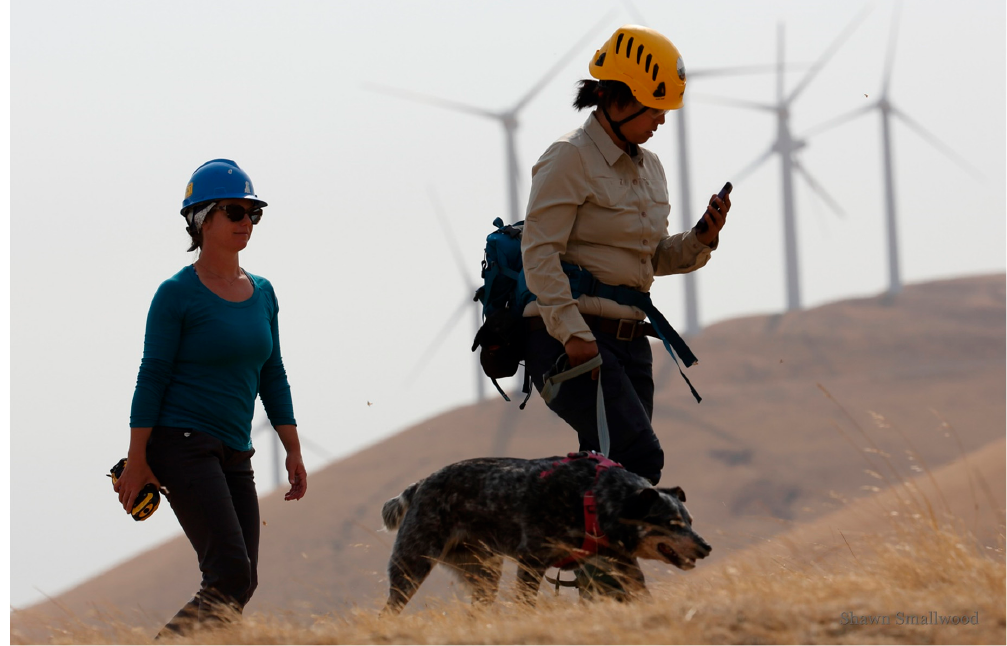
Figure 5. Jack leads handler Collette Yee and data collector/orienteer Skye Standish in a fatality search at Buena Vista Wind Energy project, California.